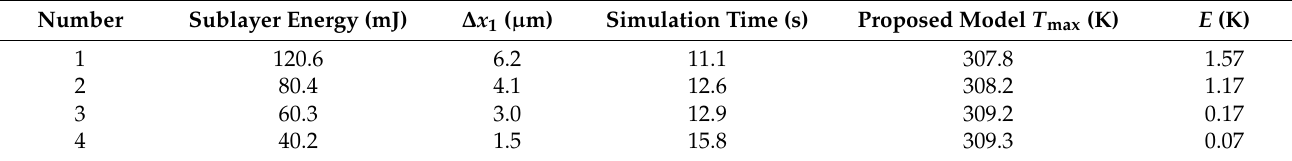
Table 1. Partial substratum division method.